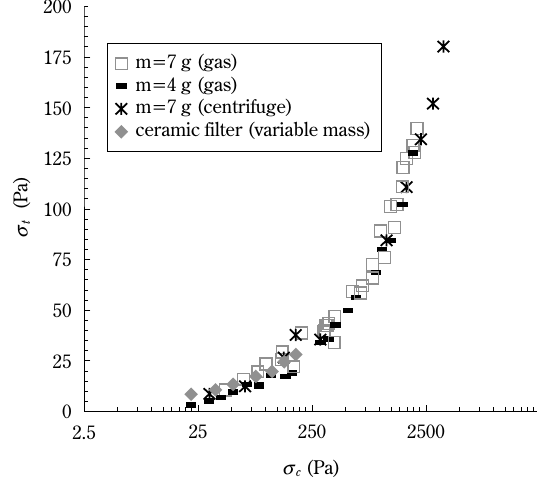
Uniaxial tensile yield stress as a function of the consolida- tion stress for an experimental xerographic toner with 0.2% concentration by weight of additive. The data from differ- ent tests using consolidation by gas (two tests with sam- ples of different masses) and centrifuging in a bed with a metallic gas distributor are plotted jointly with data obtained in a bed with a ceramic gas distributor where consolidation was increased by adding new mass to the